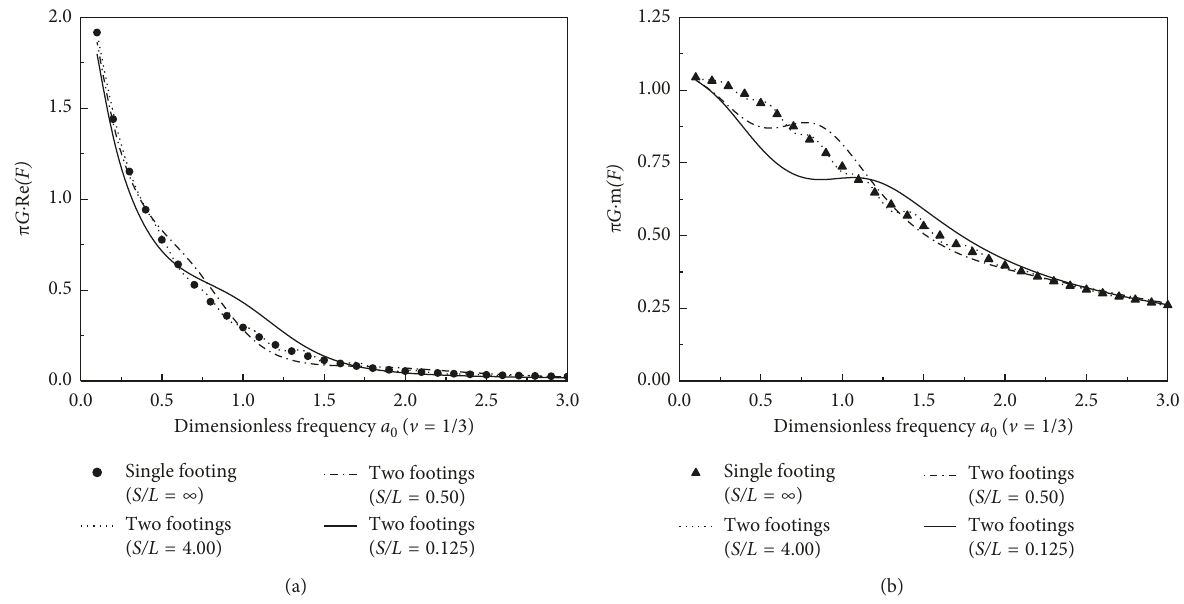
Figure 10: Vertical flexibility F ( a